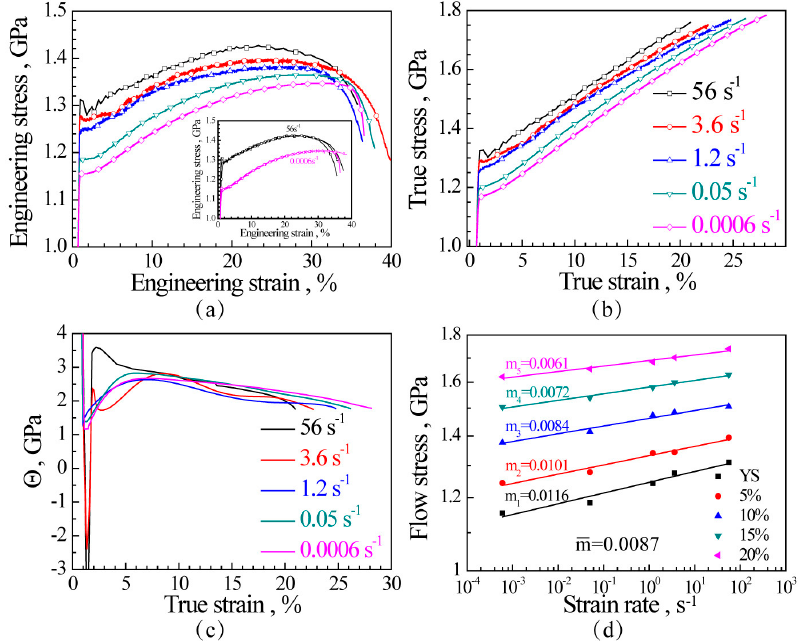
Figure 3. ( a ) Engineering stress–strain curves for the HSSS at various strain rates; ( b ) True stress–strain curves for the HSSS at various strain rates; ( c ) Strain hardening rate a function of true strain for the HSSS at various strain rates; ( d ) Yield strength and flow stresses at various true strains as a function of true strain rates in double logarithmic coordinates for the HSSS. The insets of Figure 3a show good repeatability for both tests conducted at quasi-static strain rates and intermediate strain rates. It is interesting to note that all the stress–strain curves at various strain rates show non- continuous yielding. A concave segment over a range of strains is observed for all the stress-strain curves at various strain rates, and the stress–strain curves show different yielding behaviors at various strain rates. At lower strain rates, a transient deformation stage is observed without yield drop, while at higher strain rates, a yield-peak with yield drop shows up first, followed by a transient deformation stage. As observed in Figure 3b for the strain hardening rate vs. true strain curves, the hardening rate drops rapidly first after yielding, even drops to below zero for the curves with yield drop at higher strain rates, followed by an up-turn to reach its maximum, and then decreases slowly until the necking point. In our previous paper [21], such a transient deformation stage has been found to be caused by the back stress hardening due to the deformation incompatibility between different phases over a strain regime corresponding to the elasto-plastic transition stage. Similar behavior in the hardening rate has also been found recently in the other heterogeneous materials, such as gradient structure [57,58], heterogeneous lamella structure [59] and multilayer laminates [60]. During the